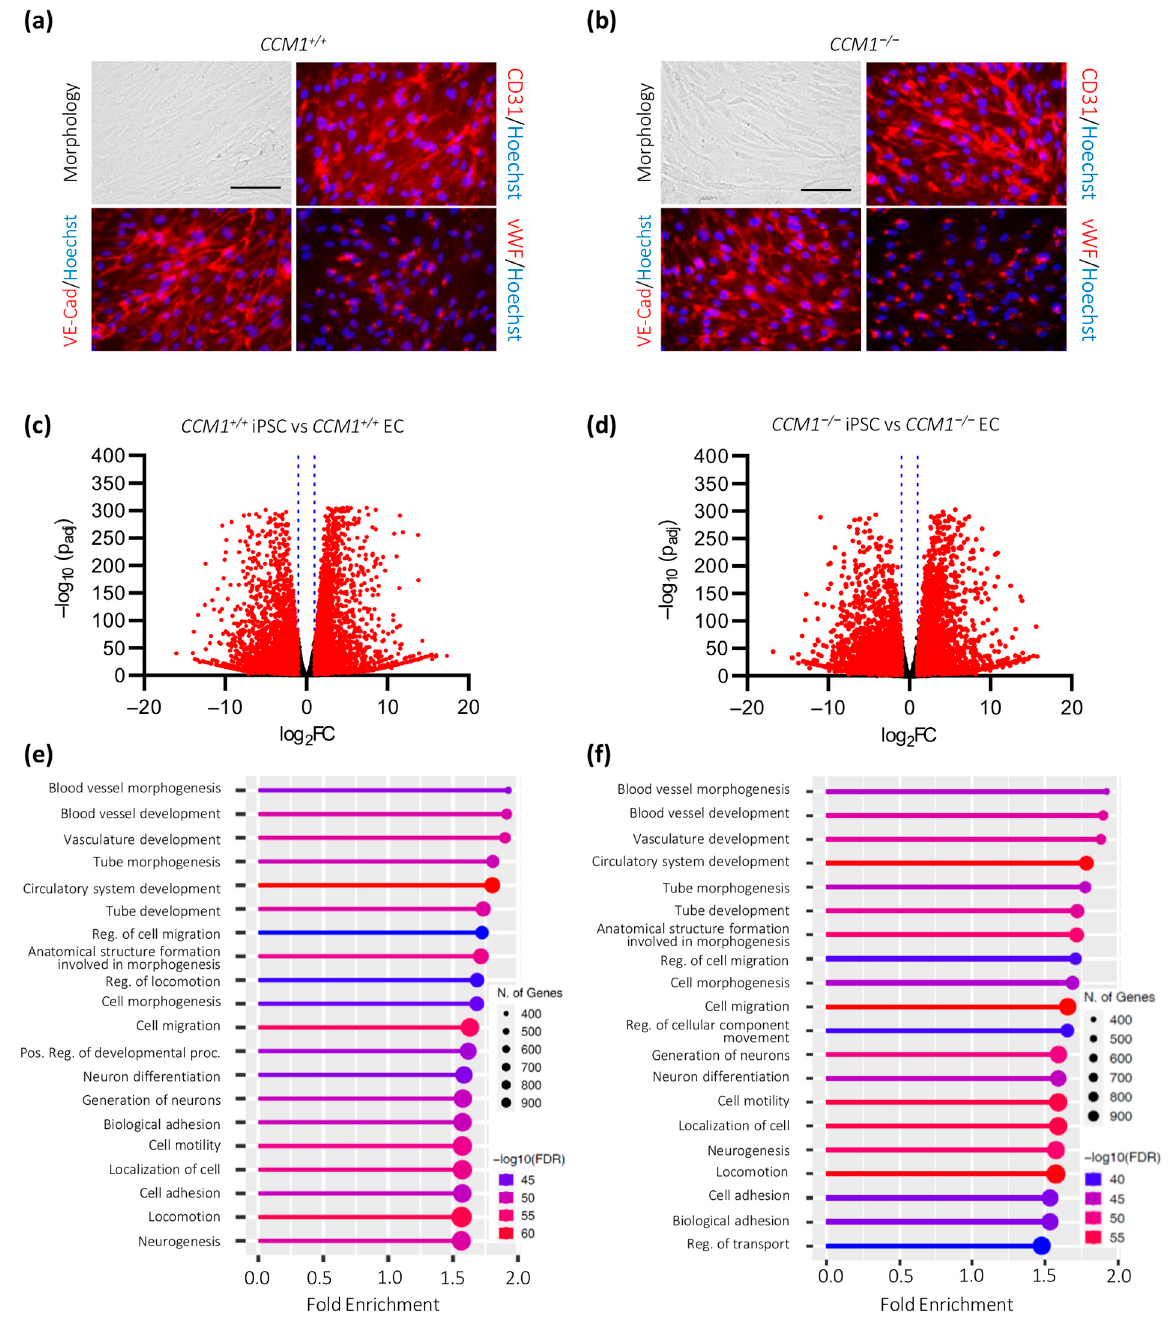
Figure 2. Targeted differentiation of iPSCs into ECs. ( a , b ) CCM1 +/+ ( a ) and CCM1 − / − ( b ) iPSC-derived ECs display typical EC morphology and express EC markers CD31, VE-Cadherin, and vWF (scale = 75 µm); ( c , d ) volcano plots of genes that are up- or downregulated upon differentiation of CCM1 +/+ ( c ) and CCM1 − / − ( d ) iPSCs into ECs. The log 2 fold changes (log 2 FC) of the normalized mean hit counts are plotted against the negative log 10 adjusted p values ( − log 10 (p adj )). Differentially expressed genes (=p adj < 0.05 and |log 2 FC| > 1) are marked in red; ( e , f ) GO biological process enrichment analysis for CCM1 +/+ ( e ) and CCM1 − / − ( f ) cells. FDR = false discovery rate. The lollipop charts were created with ShinyGO 0.76 [22]. n = 3 per genotype.